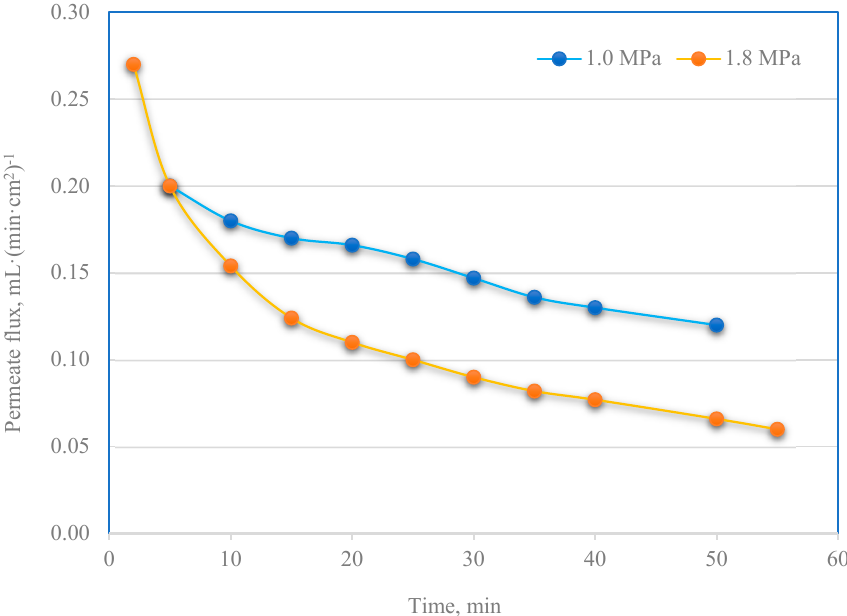
Figure 9. PPW permeate flux for NF processes vs. time (at 1.0 and 1.8 MPa of transmembrane pres ‐ sure).